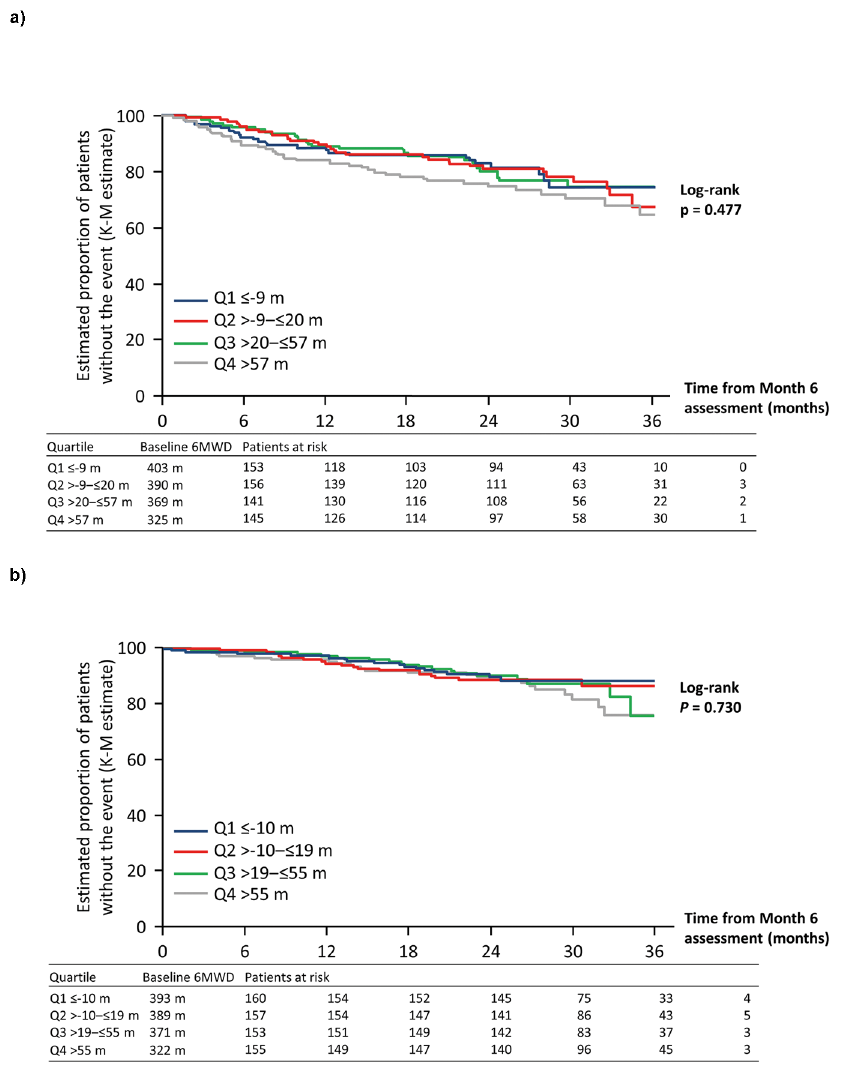
Fig 4. Association between change in 6MWD from baseline to Month 6 (by quartiles) and long-term outcomes in patients with PAH: A. PAH-related death or hospitalization up to end of treatment; B. All-cause death up to end of study. 6MWD, six-minute walk distance; K-M, Kaplan–Meier; PAH, pulmonary arterial hypertension.